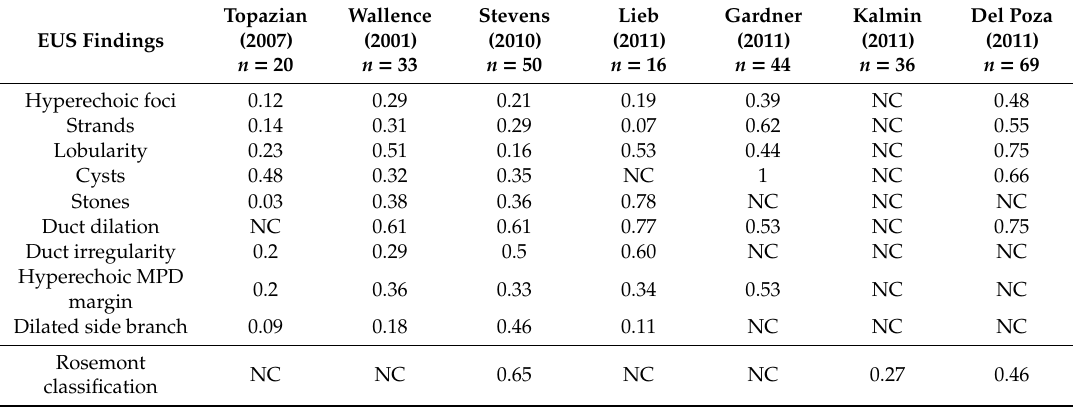
Table 1. Interobserver reliability of endoscopic ultrasonography (EUS) criteria in chronic